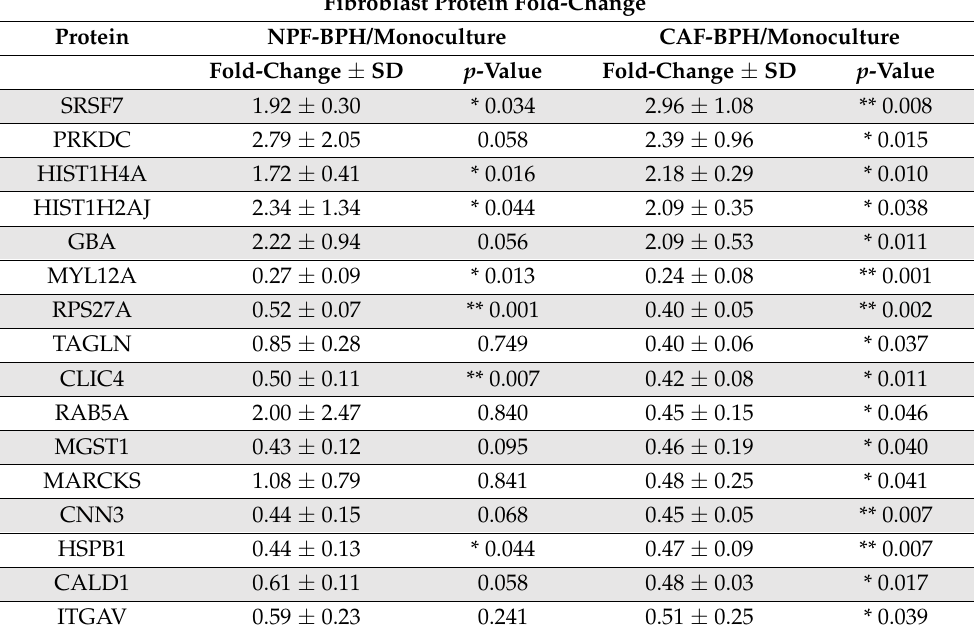
Table 2. Fibroblast protein fold-change in co-culture. Top differentially regulated proteins in CAF cells in BPH1 co-culture compared to monoculture (>twofold-change in either direction and p < 0.05) compared to NPF in BPH-1 co-culture vs. monoculture. Data are displayed as mean fold-change of raw protein intensity from mass spectrometry measurement ± SD from three biological replicates and p -value calculated from Student’s t -test comparing monoculture and co-culture. * p < 0.05, ** p < 0.01. Fibroblast Protein Fold-Change Protein NPF-BPH/Monoculture